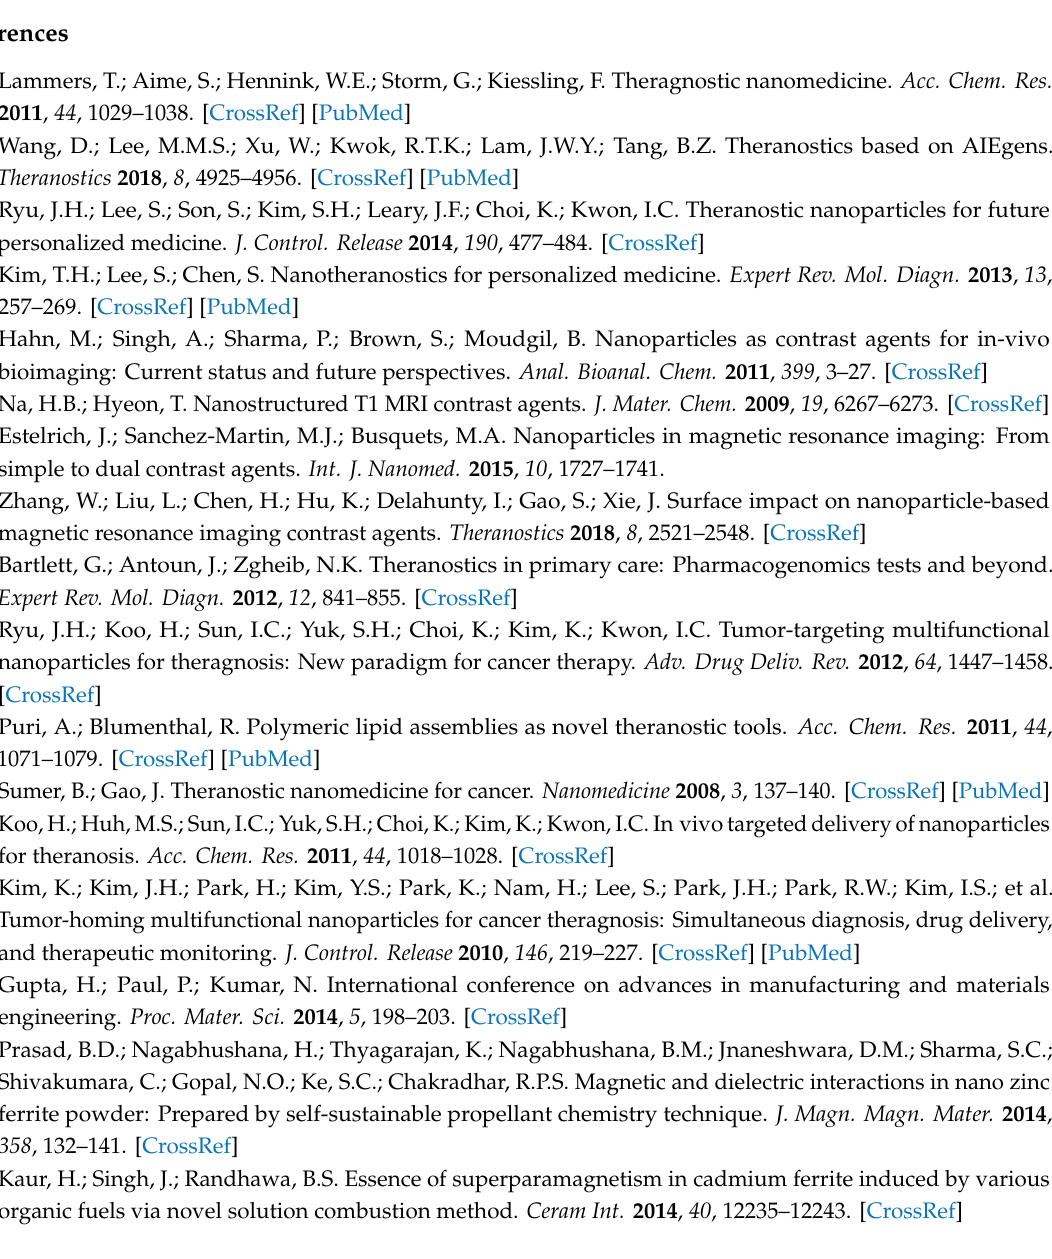
Table S1. FCF NP concentration-dependent T2 relaxation rate in each cancer cell. Figure S1: fluorescence imaging of FCF NP-treated cancer cells. Figure S2: fluorescence imaging for in vitro cytotoxicity of FCF NPs in various cell lines. Figure S3: photodynamic Ce6 anticancer activity in various cancer cells. Figure S4: photodynamic FC and FCF NP anticancer activity in various cancer cells. Figure S5: fluorescence images showing phototoxicity in cancer